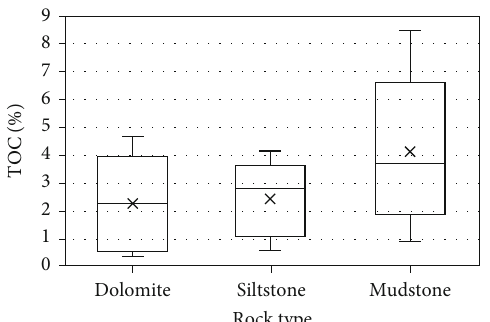
Figure 13: Box diagram of TOC value distribution of rock samples from Lucaogou formation.